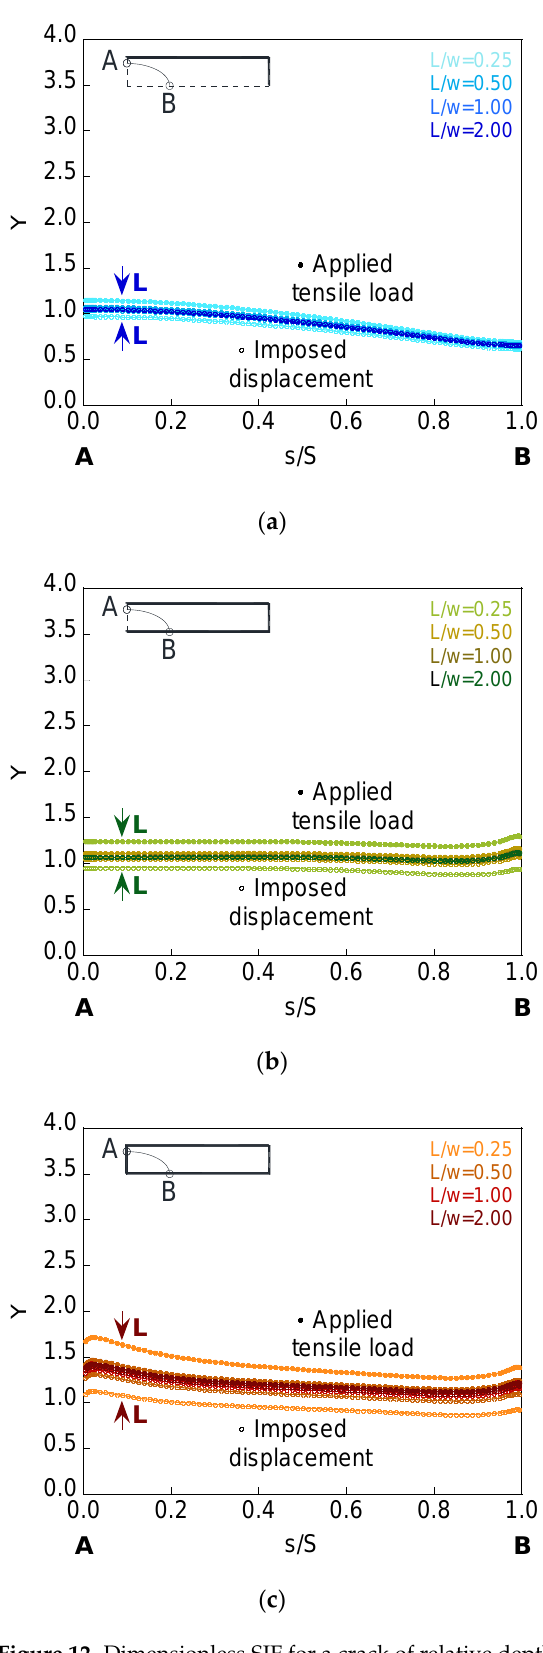
Figure 12. Dimensionless SIF for a crack of relative depth a / t = 0.8 and aspect ratio a / b = 0.5 in finite- thickness plates of relative lengths L / w = {0.25, 0.50, 1.00, 2.00} for the ( a ) embedded configuration, ( b ) superficial configuration, and ( c ) corner configuration.